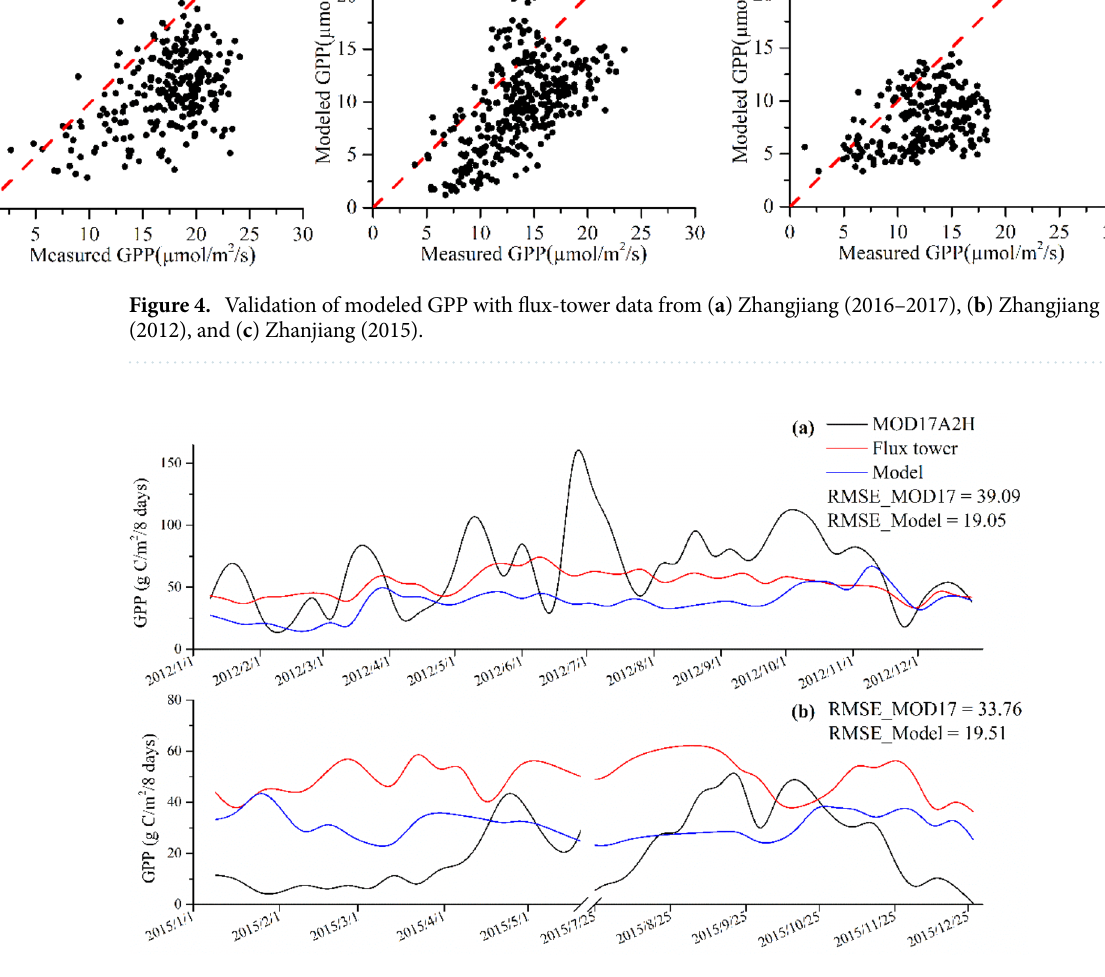
Figure 5. Time-series GPP comparisons among MODIS products, in-situ measurements, and mangrove GPP model generated in this study: ( a ) Zhangjiang (2012) and ( b ) Zhanjiang (2015).